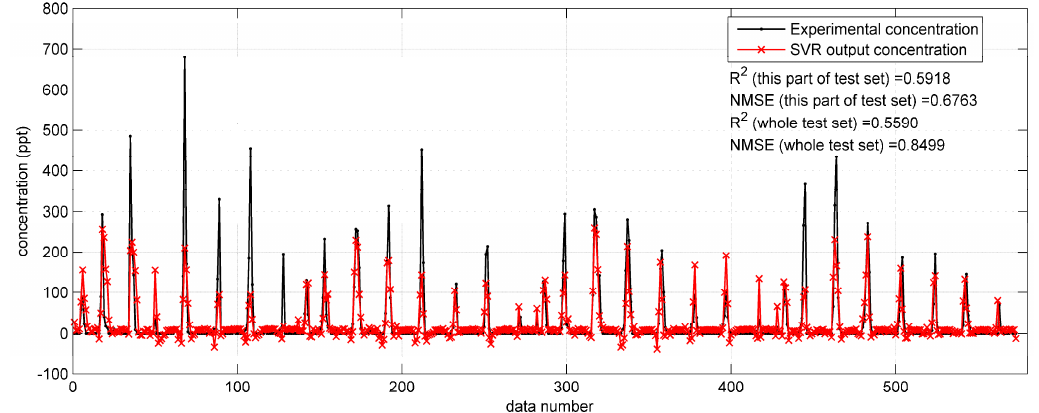
Figure 9. The prediction results of SVR with integrated Gaussian parameters on the data from 11:00 a.m. to 2:00 p.m. on 17 September (a part of the test set) in the Indianapolis case.